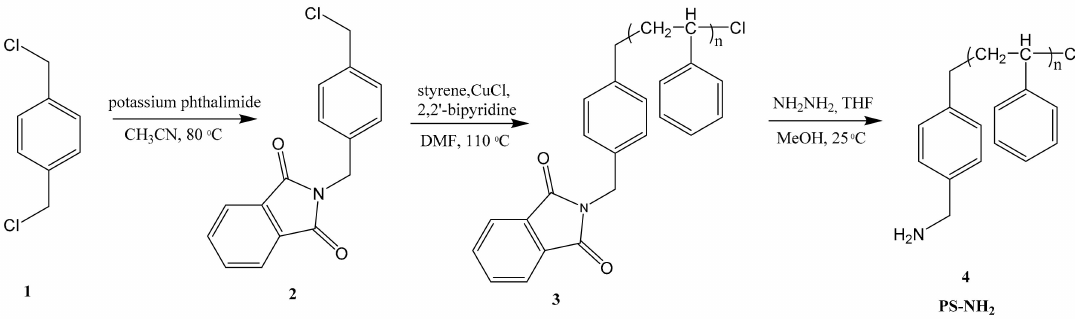
Scheme 1. Synthesis route for amine-end-functionalized PS–NH 2